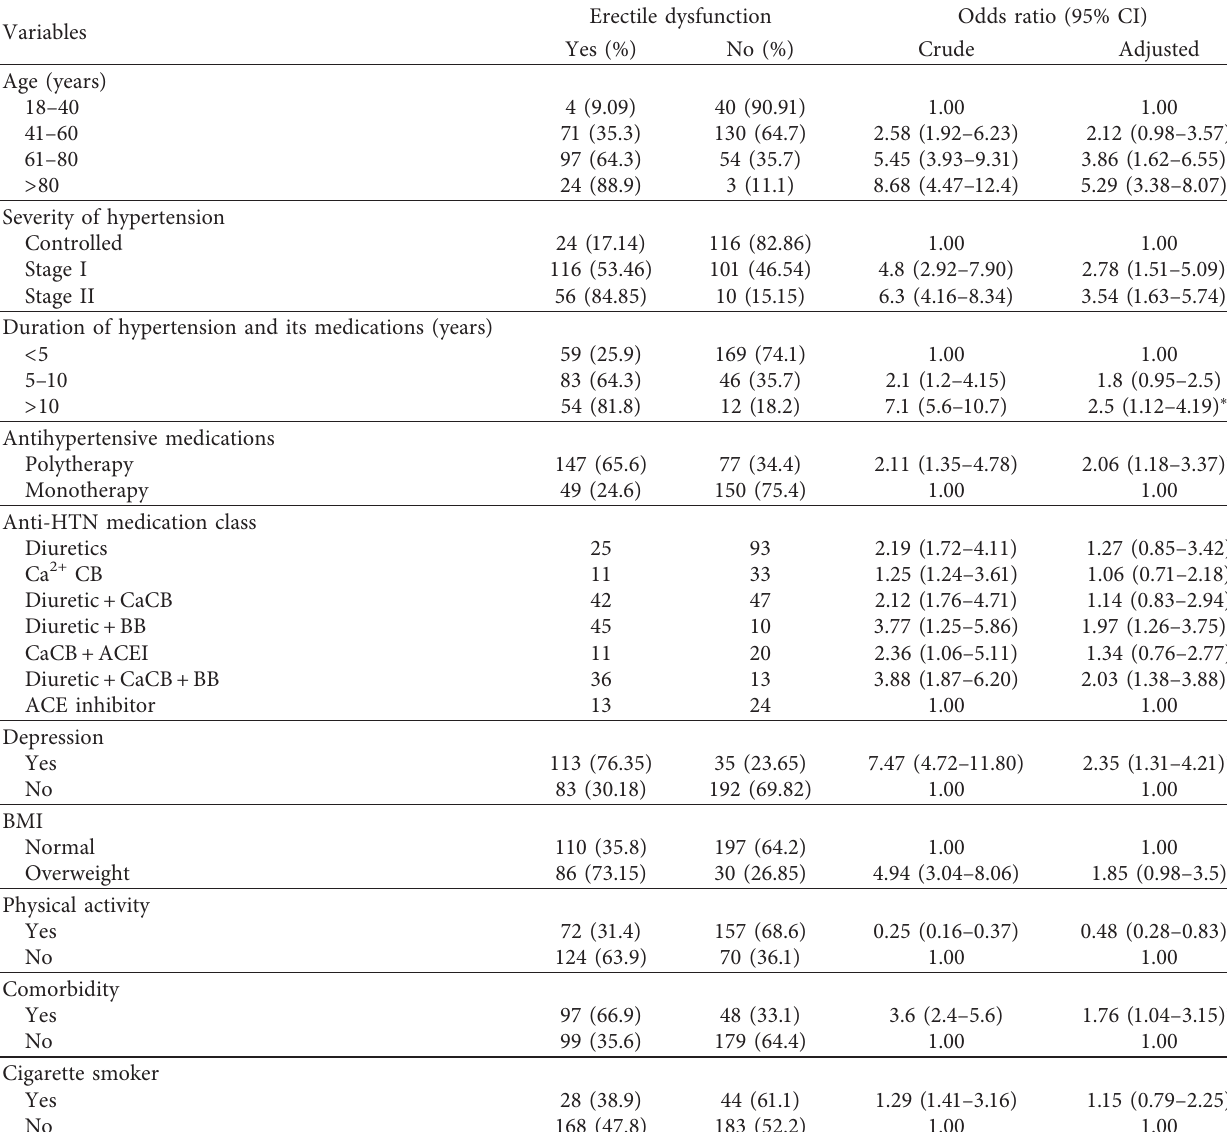
Figure 2: Prevalence and severity of erectile dysfunction based on age group of study participants attending governmental health in- stitutions in Gondar city, Northwest Ethiopia, 2021 ( n � 423). Table 3: Bivariable and multivariable logistic regression analysis of factors associated with erectile dysfunction among hypertensive patients attending governmental health institutions in Gondar city, Northwest Ethiopia, 2021 ( n �